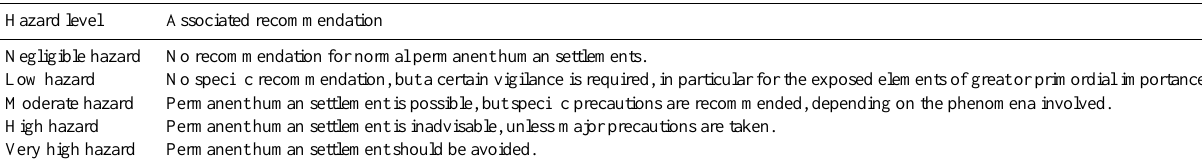
Table 5. Example of possible generic recommendations associated with each hazard level.